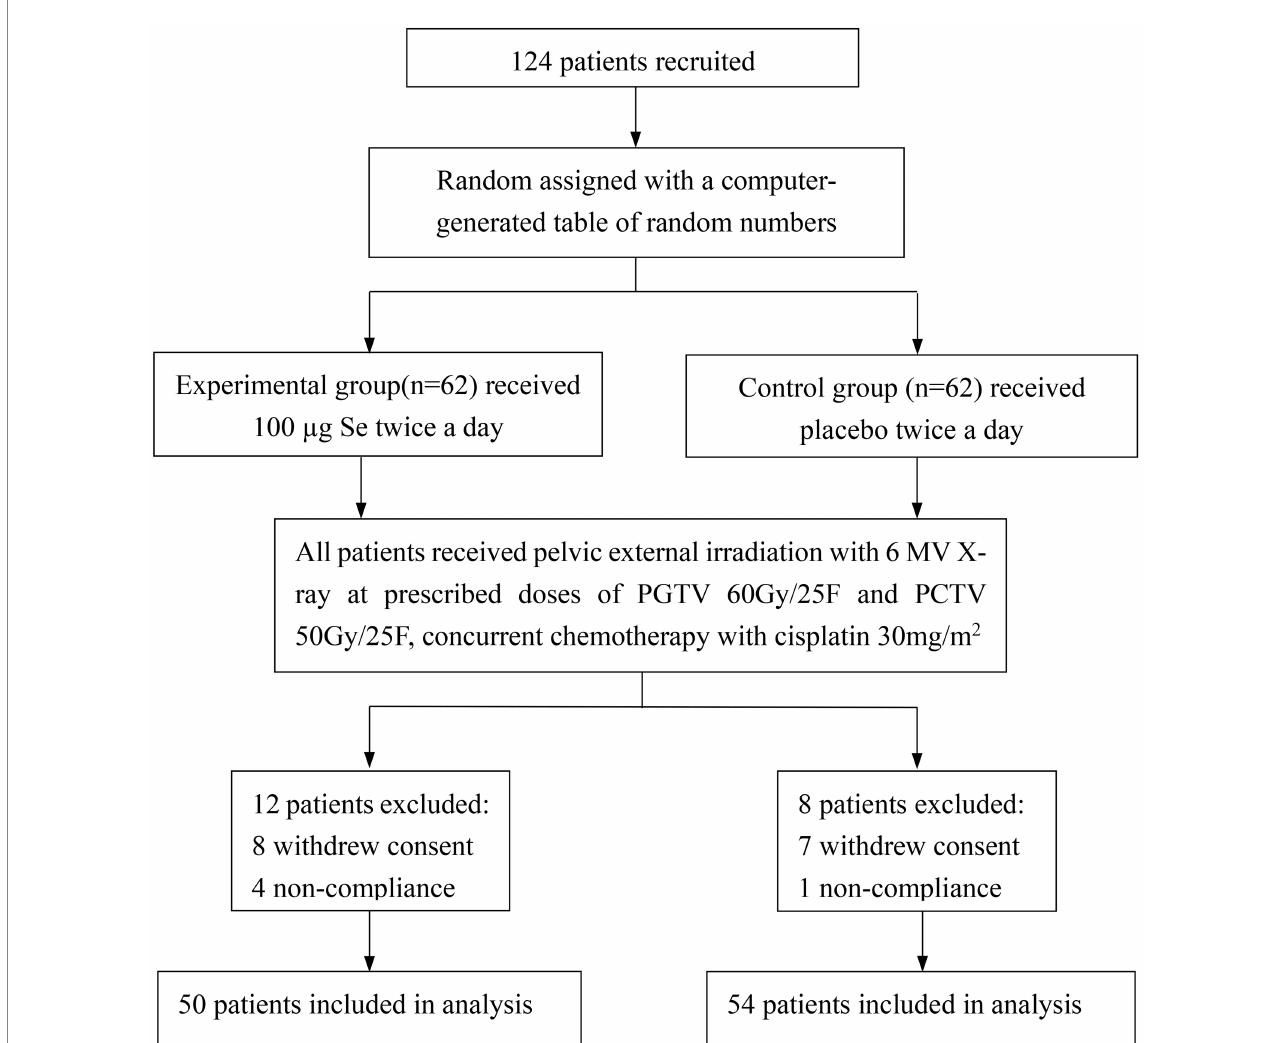
FIGURE 1 Trial profile. PGTV, planning gross tumor volume; PCTV, planning clinical target volume; CR, complete response; PR, partial response; SD, stable disease; PD, progressive